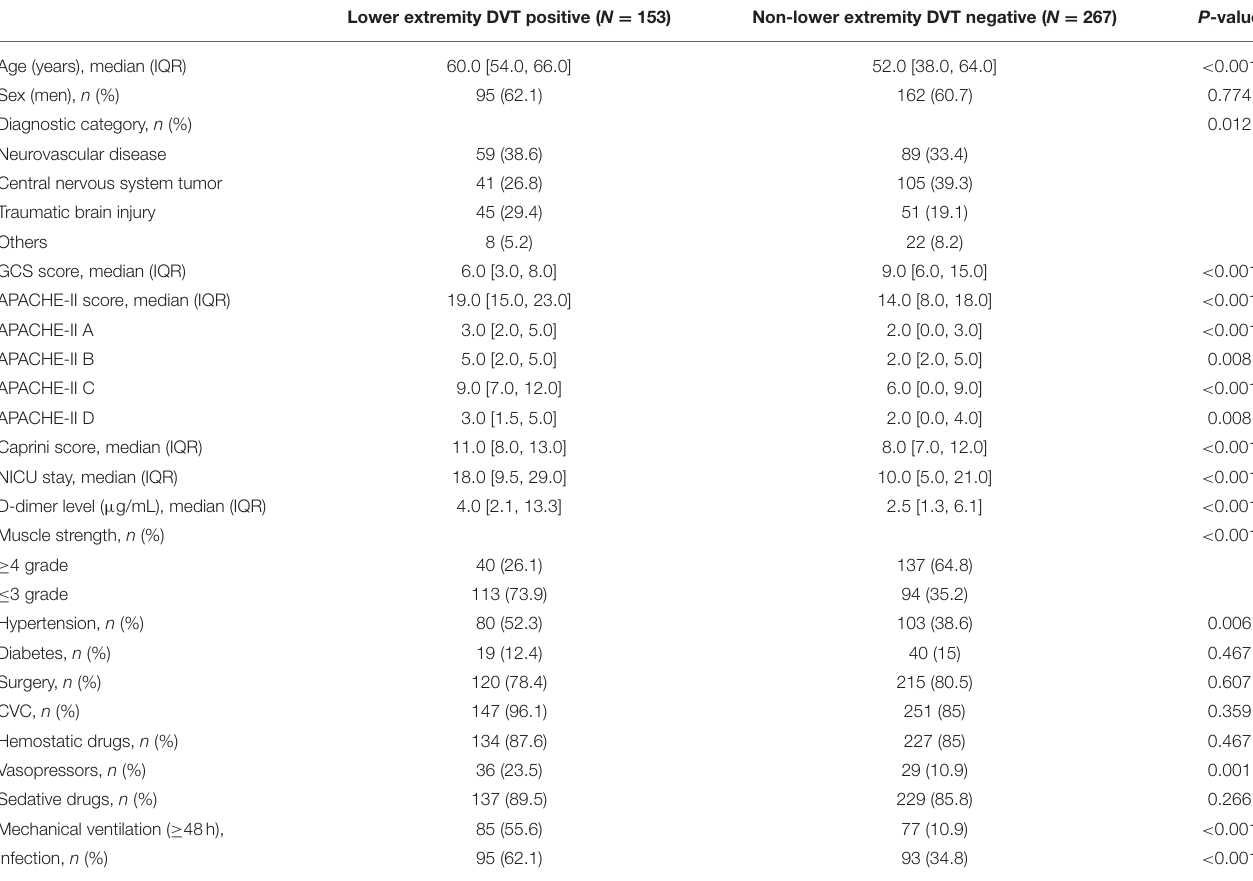
TABLE 2 | Results of univariate analysis of risk factors for lower extremity DVT in the primary cohort. Lower extremity DVT positive ( N = 153)